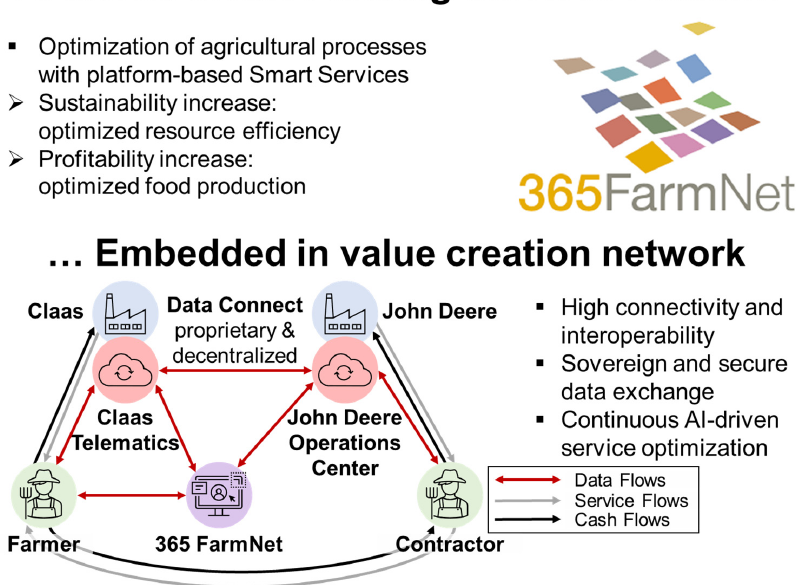
Figure 4. Smart farming services as an example of ‘digitainabilized’ platform-based business models (Own Illustration based on Plattform Lernende Systeme [58] (p. 16)).